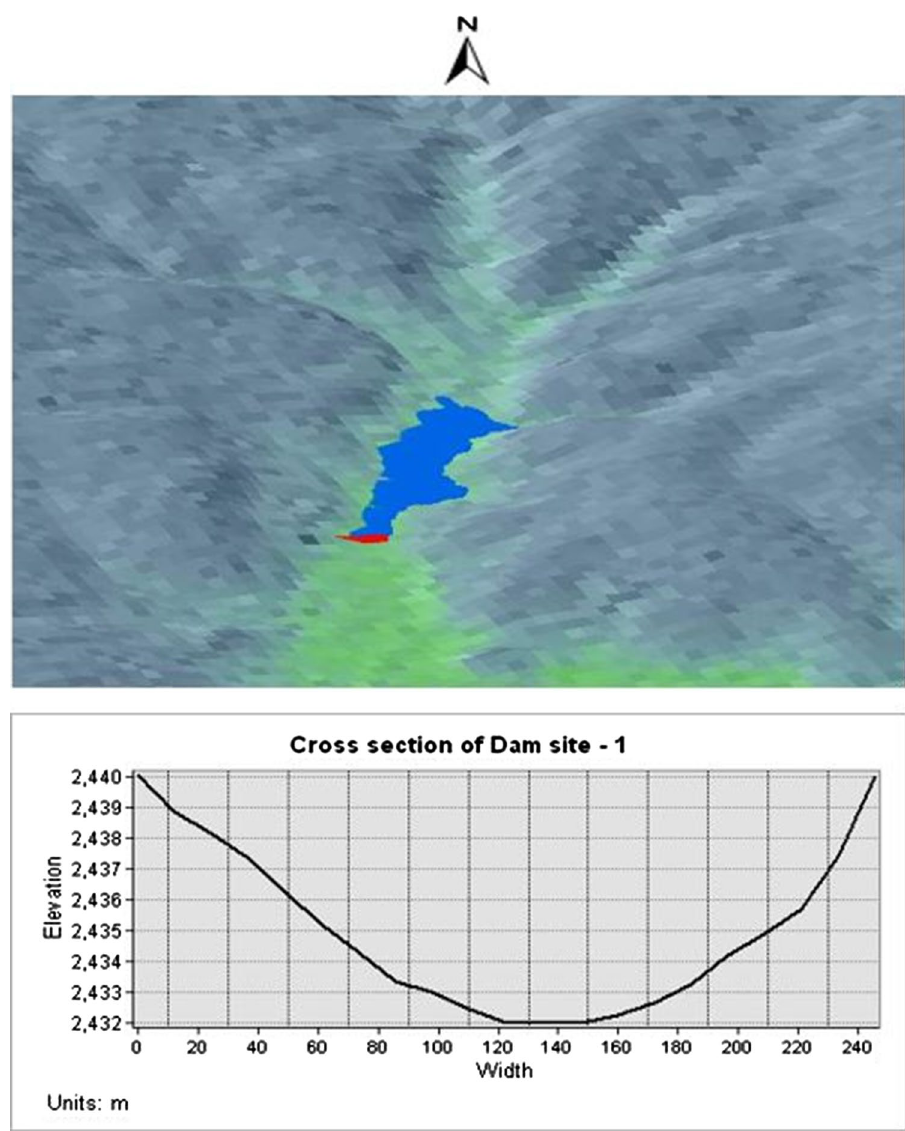
Fig. 13 3D view and cross sec- tion of proposed dam